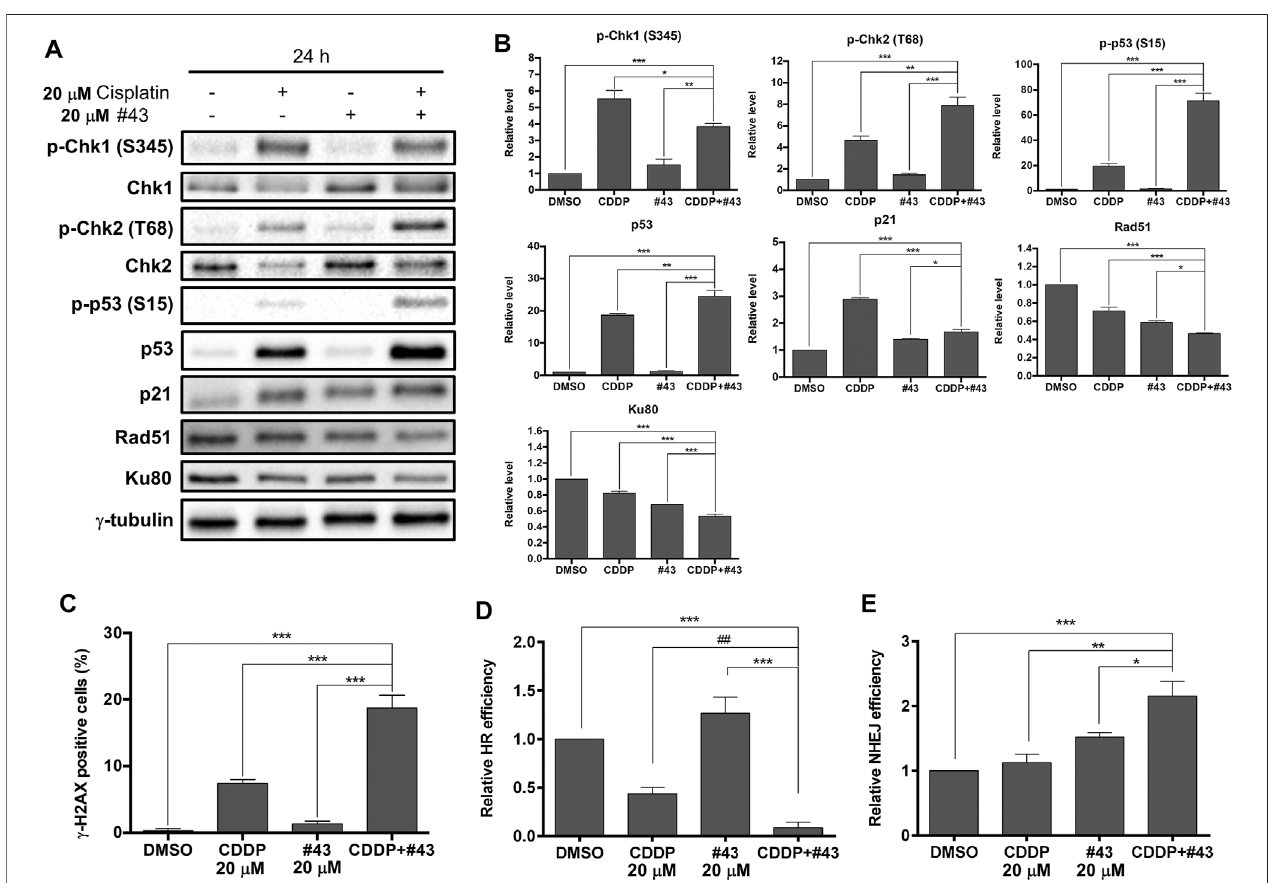
FIGURE 5 | Effects of cisplatin and #43 on DNA damage response and DNA repair in MCF-7 cells. (A) Western blot analysis of DNA damage response and DNA repair-related proteins (B) Quantitative results of Western blot analysis. MCF-7 cells were treated with 20 μ M cisplatin and/or 20 μ M #43 for 24 h, and harvested for Western blot analysis. The relative protein levels were quanti fi ed by Image Lab software using γ -tubulin as the loading control. (C) Quantitative results of γ -H2AX immuno fl uorescence staining. MCF-7 cells were treated with 20 μ M cisplatin and/or 20 μ M #43 for 12 h, followed by immuno fl uorescence staining. Cells containing fl uorescence intensity above the de fi ned threshold were counted as γ -H2AX positive, and at least 100 cells were counted for each sample. (D) Quantitative results of HR assay. (E) Quantitative results of NHEJ assay. Cells for HR and NHEJ assays were treated with 20 μ M cisplatin and/or 20 μ M #43 for 24 h. Data are presentedasmean±SEMofatleastthreeindependentexperiments.*, p < 0.05;**, p < 0.01;***, p < 0.001byone-wayANOVAfollowedbyBonferroni t -test. ## , p < 0.01 by the two-tailed Student ’ s t